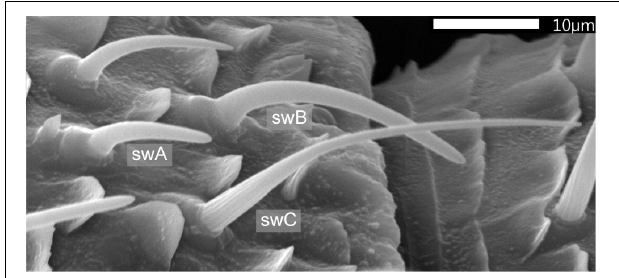
FIGURE 1 | Scanning electron micrograph of the distal edge of a round-shaped segment from the middle antennal region of the male cockroach. Two main types of olfactory sensilla were distinguished according to external features: sensilla basiconica and trichoidea. Based on their wall structures, Schaller (1978) subdivided the basiconic sensilla into single-walled type A ( swA ; length, 8–12 µ m; base diameter, 2–3 µ m) and single-walled type B ( swB; length, 18–28 µ m; base diameter, 3–4 µ m). The trichoid sensilla include the single-walled type C ( swC ; length, 30–40 µ m; base